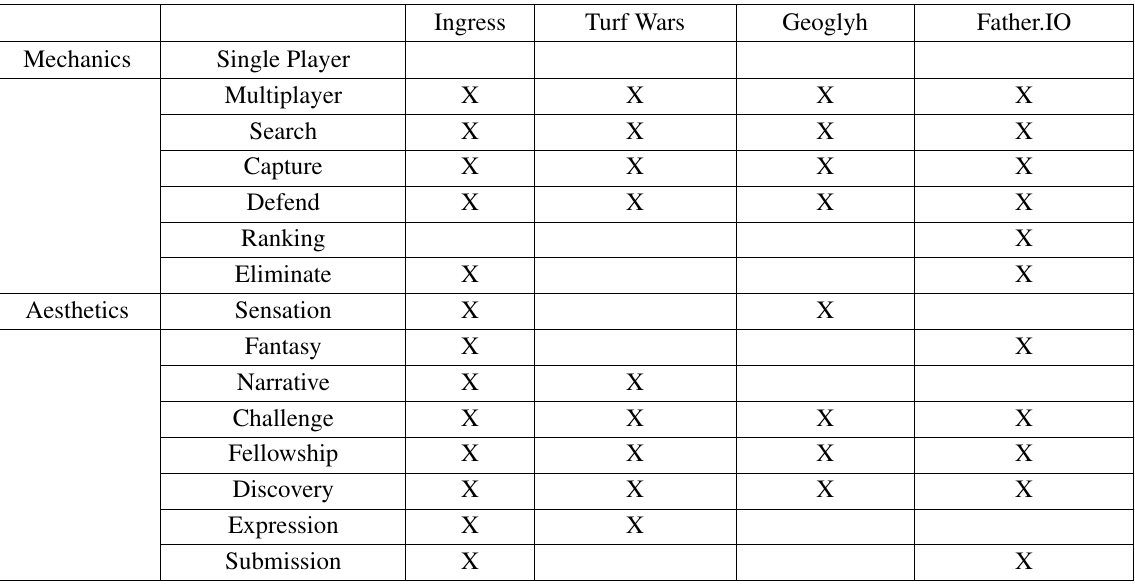
Table 3. Breakdown for Territory defense games